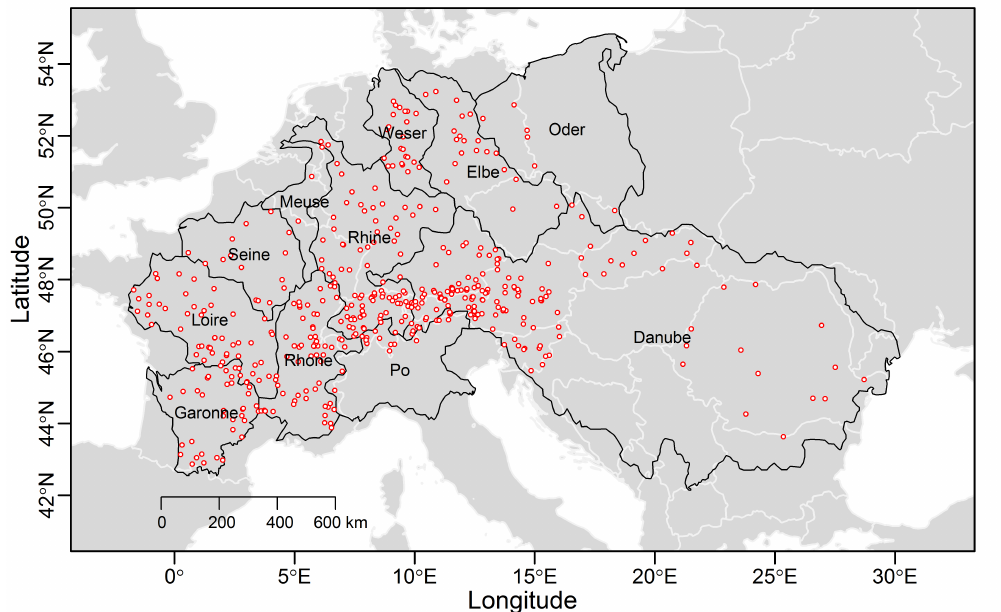
Figure 1. Map showing the location of the 473 stations included in this